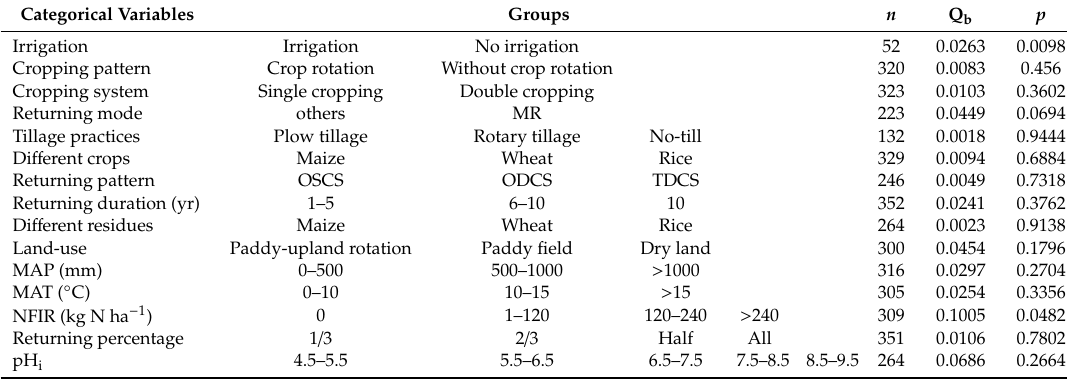
Table 1. Di ff erent categories in categorical meta-analysis of soil organic carbon (SOC) storage response to crop residue returning